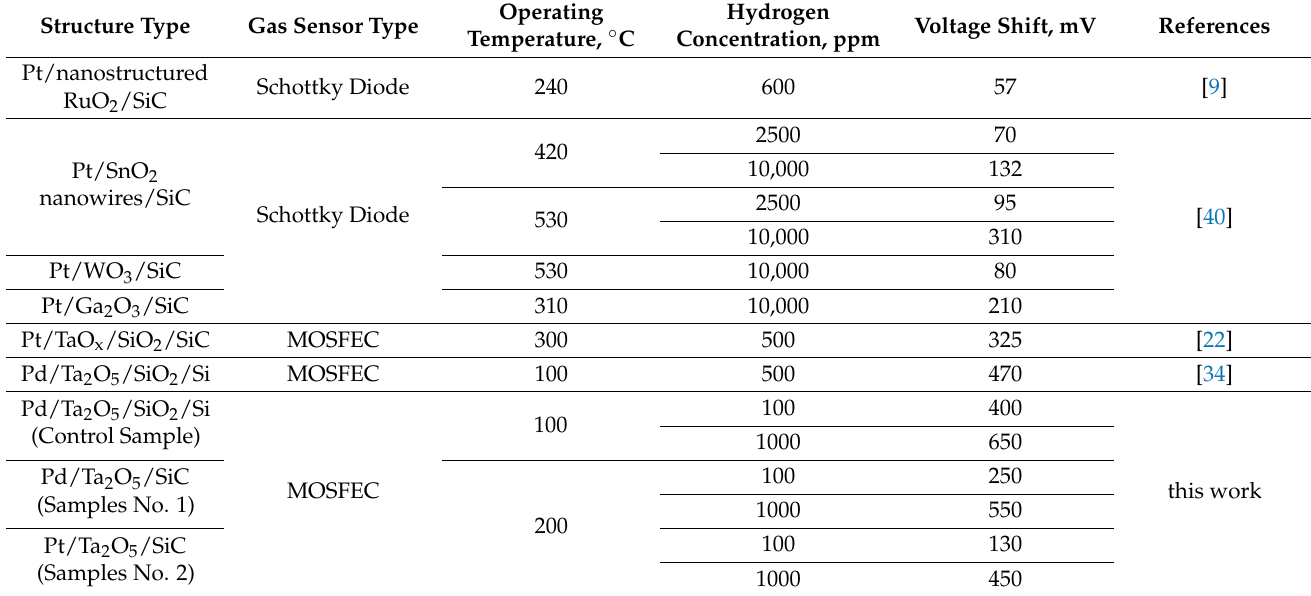
Table 5. The comparison of the experimental samples’ parameters studied in this work with the other authors’